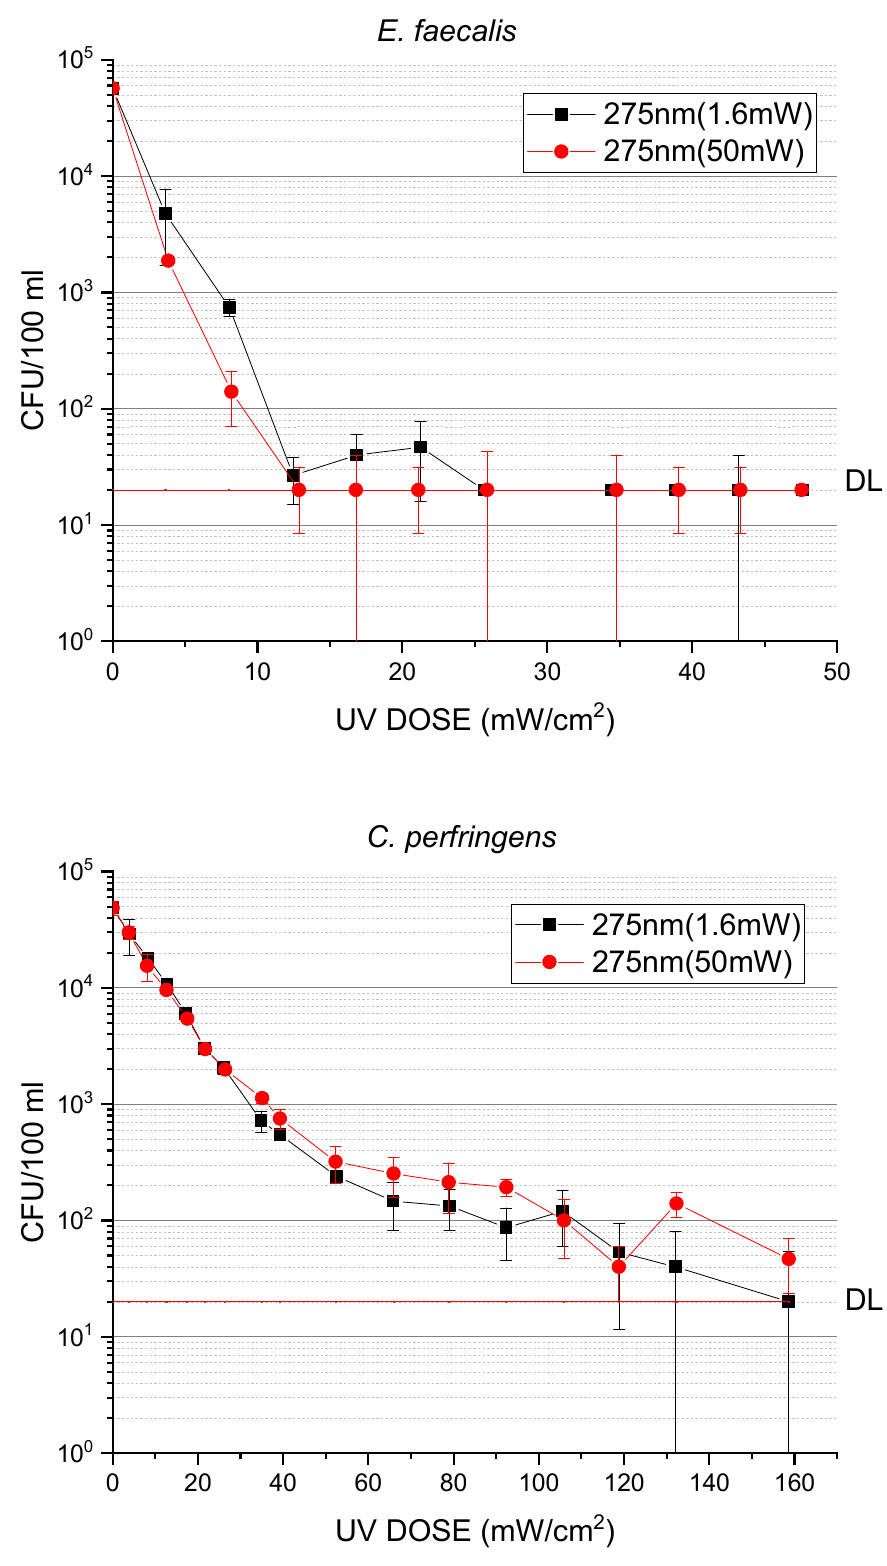
Figure 5. UV-LED disinfection results for E. coli , E. faecalis, and C. perfringens at 275 nm under two different optical power UV-LEDs (1.6 mW and 50 mW) maintaining the same UV dose. *DL—De- tection limit.